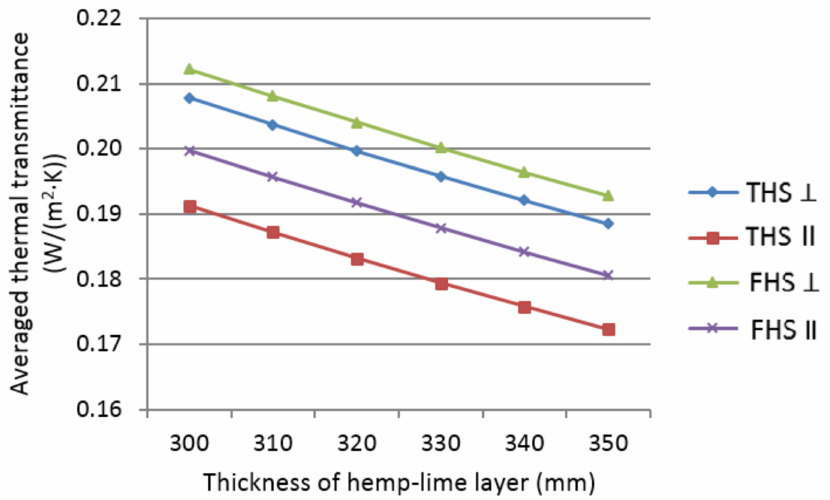
Figure 10. Averaged thermal transmittance coefficient of walls insulated with the analyzed compos- ites, depending on the thickness of the hemp-lime composite